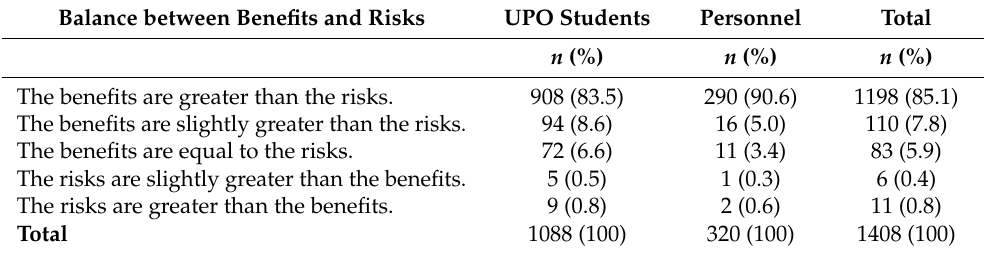
Table 2. Perception of benefits and risks associated with biomedical research. Balance between Benefits and Risks UPO Students The benefits are greater than the risks. The benefits are slightly greater than the risks. The benefits are equal to the risks. The risks are slightly greater than the benefits. The risks are greater than the benefits.